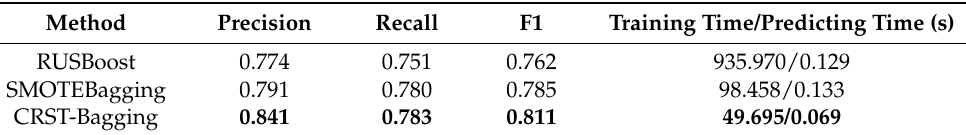
Table 3. The experimental results of RUSBoost, SMOTEBagging, and CRST-Bagging on the original dataset using seven-fold cross-validation. Method Precision Recall F1